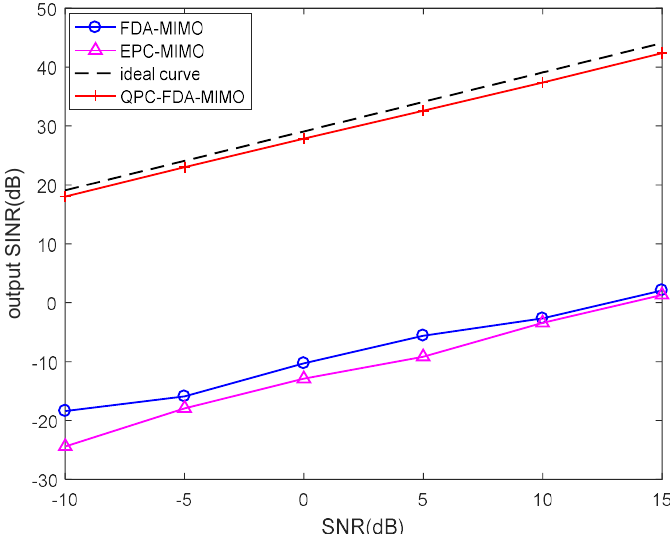
Figure 10. Output SJNR performance with respect to input SNR.